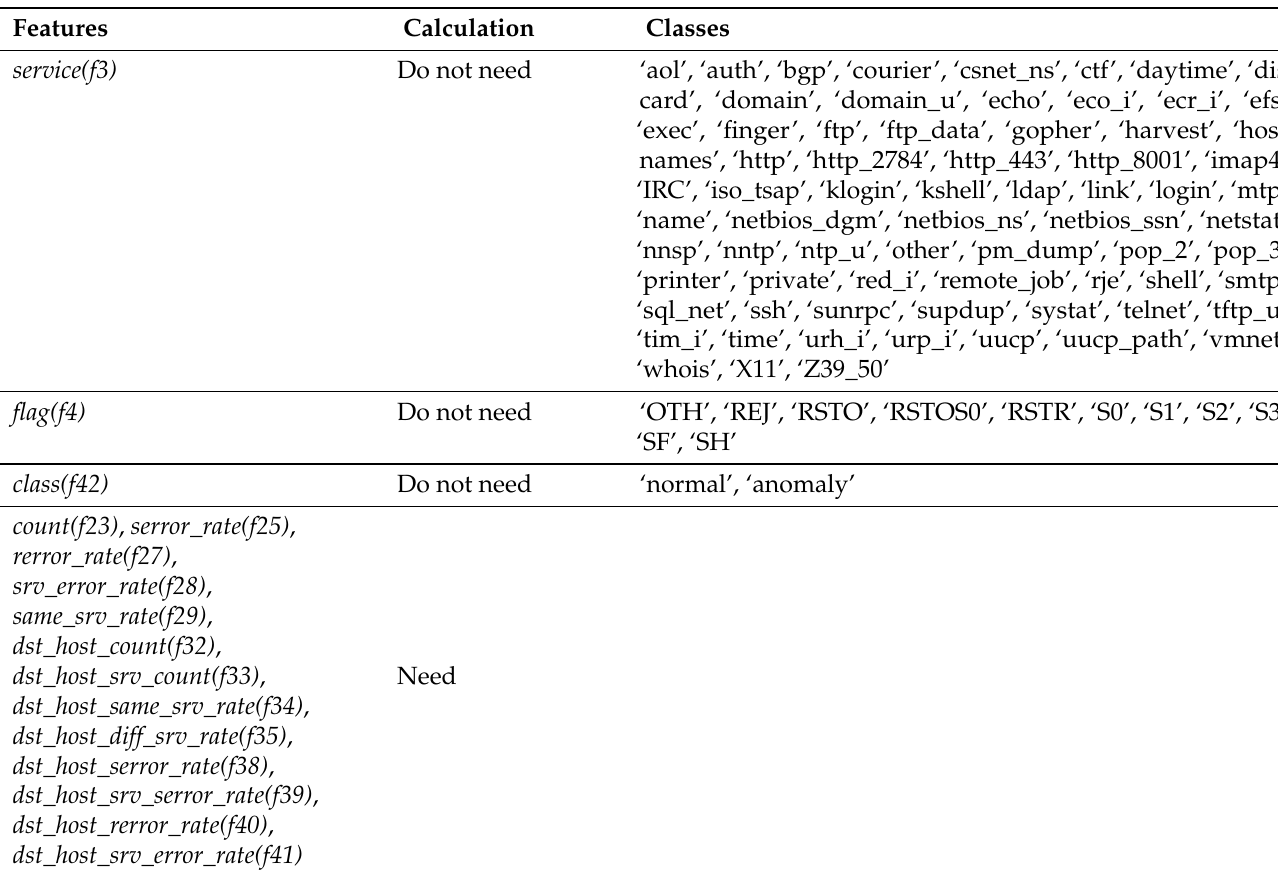
Table 1. Feature Definition.